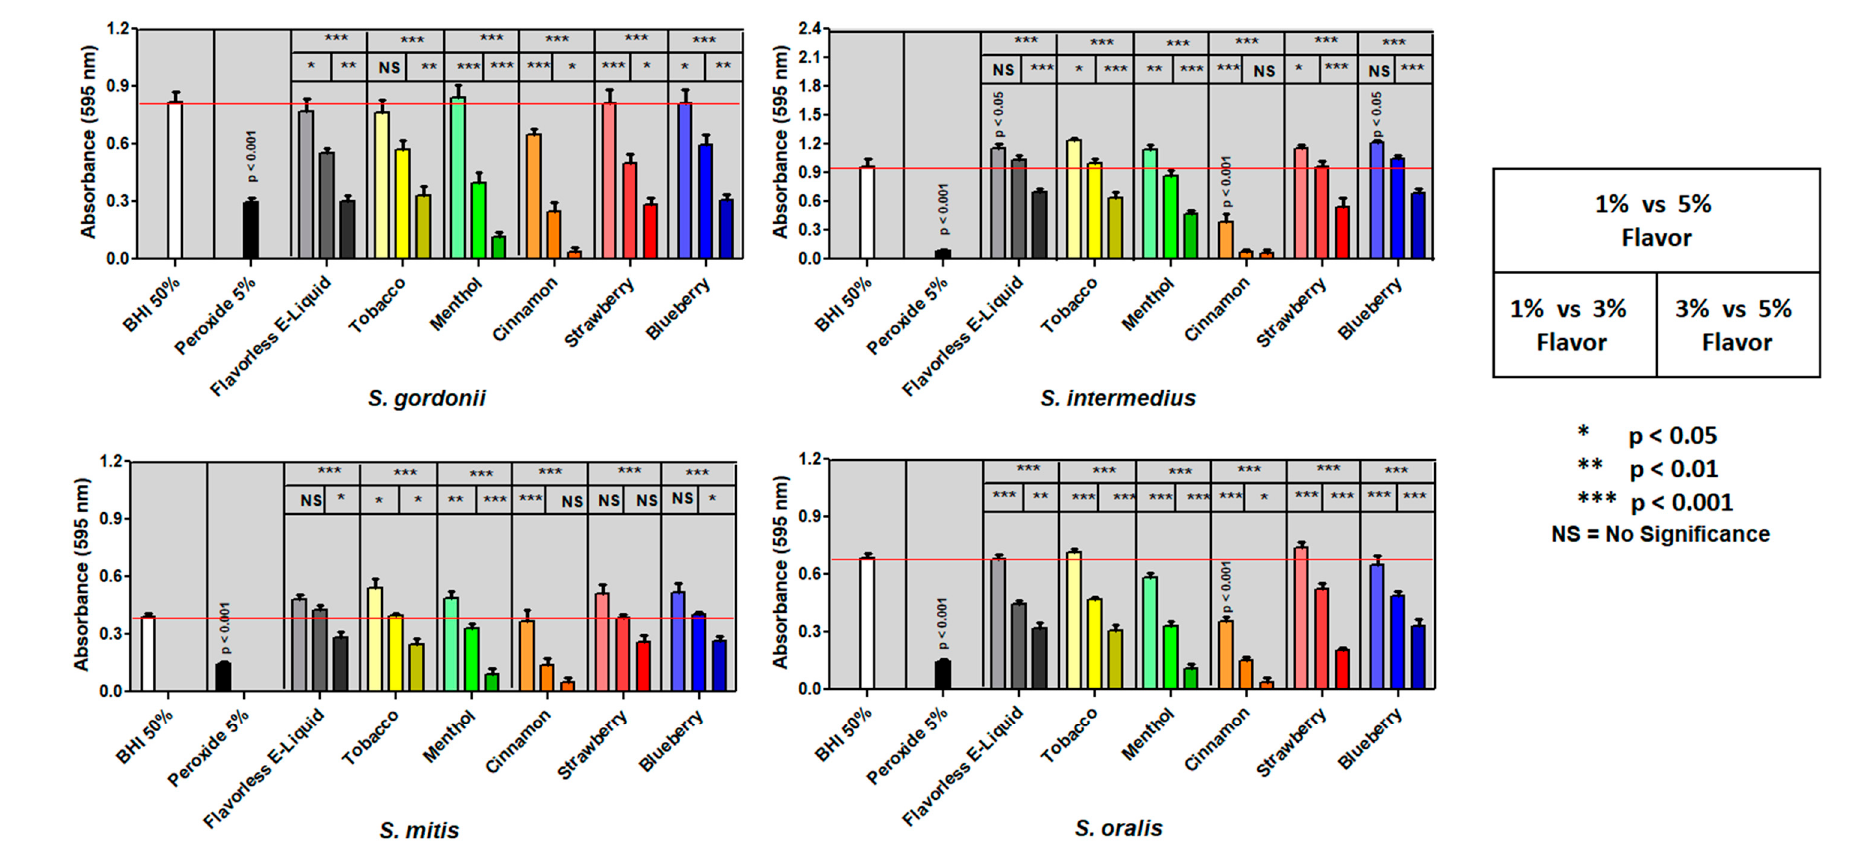
Figure 1. Dose-Dependent effect of E-liquids on Single-Species Biofilm Formation. Oral streptococci single-species biofilms biomass after treatment with 1, 3, and 5% E-liquids ± flavorings in 50% BHI. The color gradient for each E-liquid ± flavors ranges from light to dark indicating an increasing E-liquid percent. The given p values indicate significance between BHI 50% (positive control) and 5% peroxide (negative control) or BHI 50% and 1% E-liquid ± flavors using One-Way Anova. The red line indicates the average absorbance of the positive control. Three boxes above each E-liquid ± flavors indicate significance between them using Two-Way Anova. Each bar represents mean ± SE of absorbance ( n = 10 to 24).